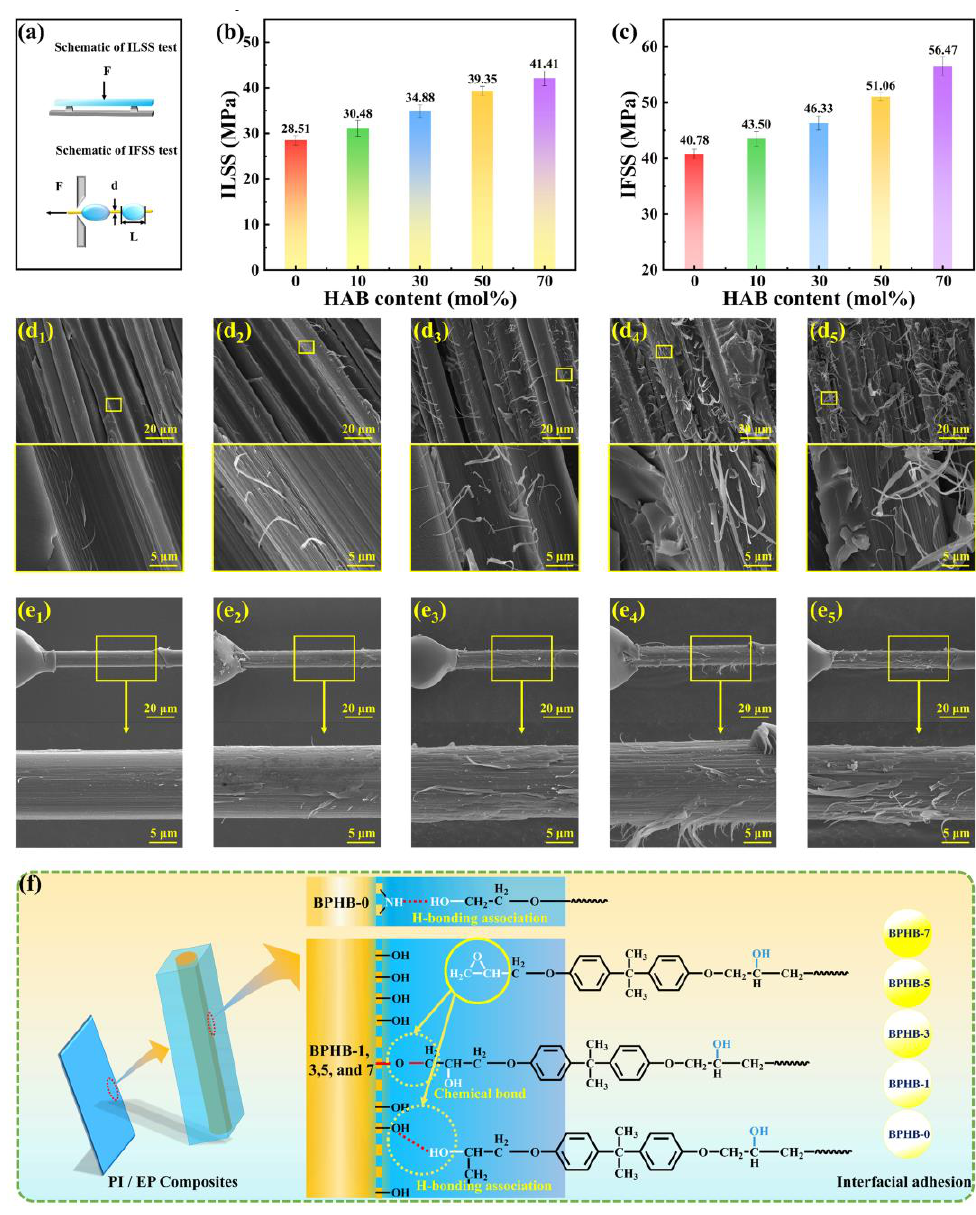
Figure 7. ( a ) Schematic of ILSS and IFSS test. ( b ) ILSS values and ( c ) IFSS values for the BPHB fibers. ( d 1 – d 5 ) Fracture images of the ILSS test, and ( e 1 – e 5 ) failure images of the IFSS test for the PI/EPs, in which the fibers have p -PDA/HAB/BIA molar ratios of 7/0/3, 6/1/3, 4/3/3, 2/5/3, and 0/7/3, respectively. ( f ) Interfacial interaction mechanism of the unidirectional PI/EPs.